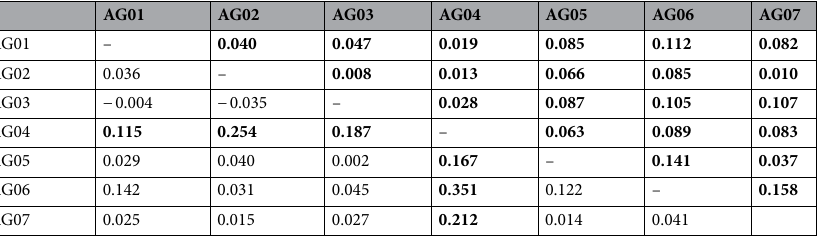
Table 4. Pairwise genetic differentiation ( F ST ) based on mitochondrial COI region sequences (below diagonal) and ten microsatellite loci genotypes (above diagonal) for seven populations of Asynapta groverae from South Korea. Significant values ( P < 0.05) are in bold.